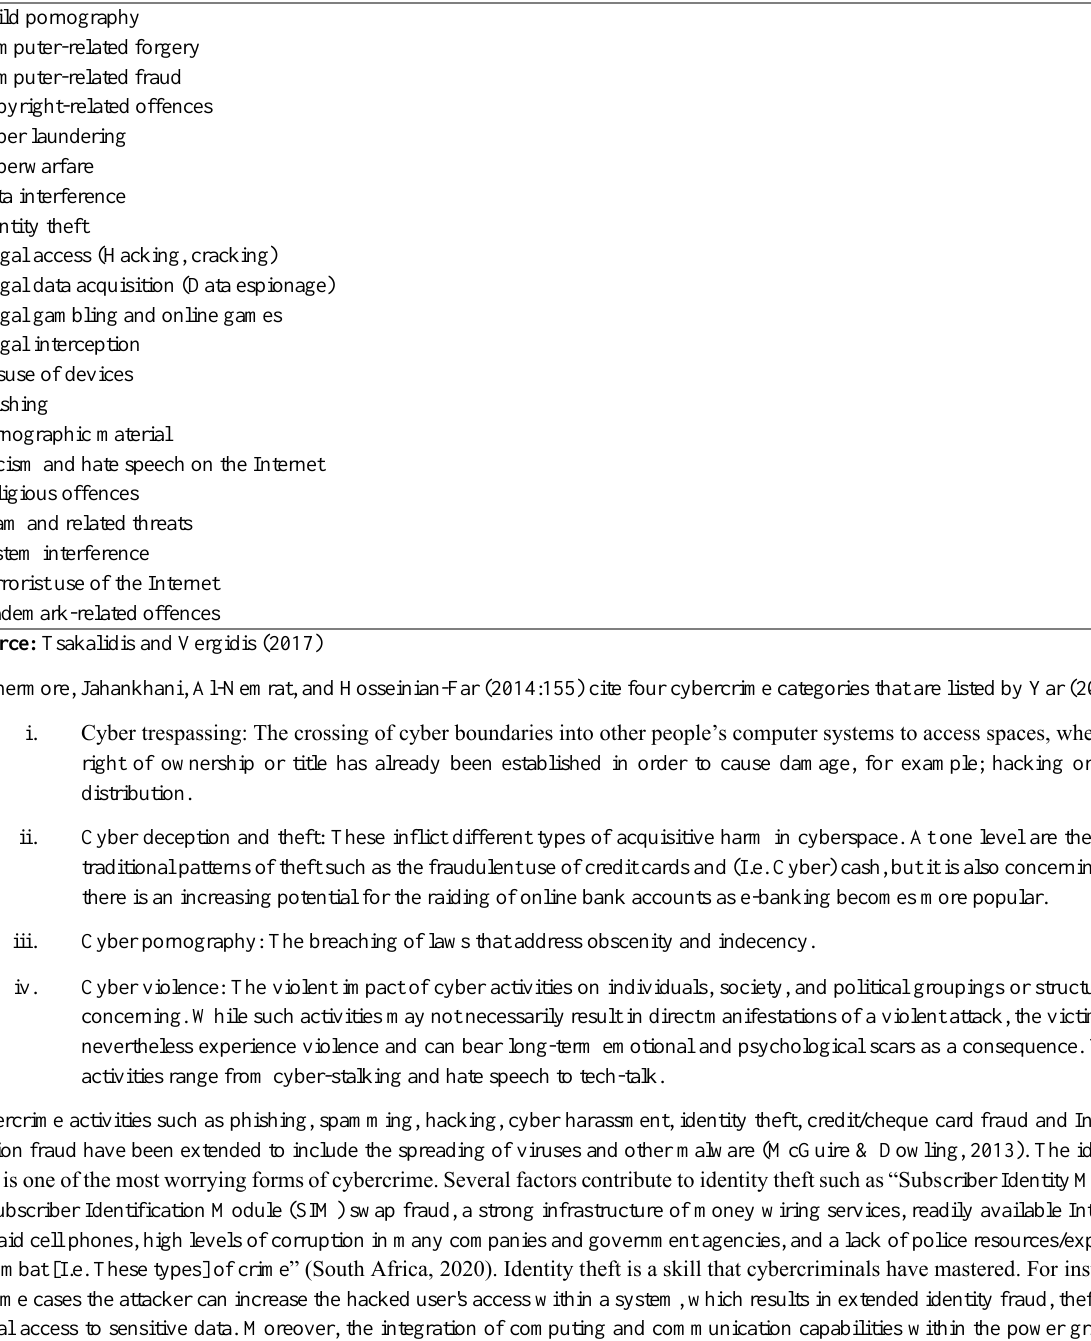
Table 1: List of cybercrime-related